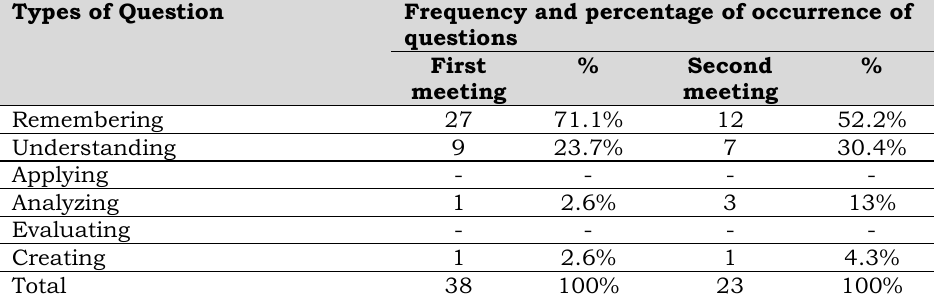
Table 1 : The Occurrence of Teacher